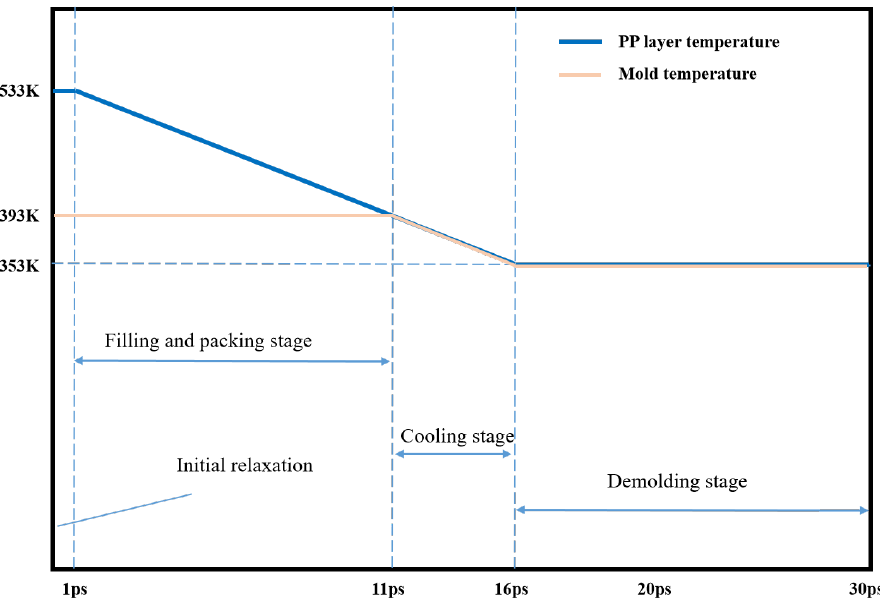
Figure 2. Time and temperature settings of simulation procedure for the injection molding process.